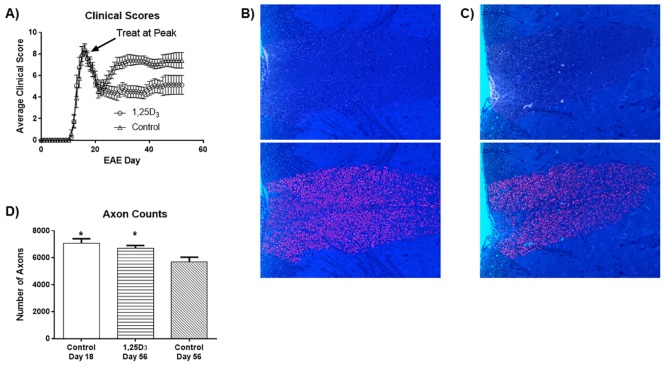
Treatment of EAE mice at peak disease demonstrates sustained improvement in clinical score and sparing of axons.Thirty-six mice were immunized with MOG, and 4 mice were sacrificed at day 18 for baseline histology. The remaining 32 mice were equally divided into 1,25D3 or vehicle treatment group until the end of the experiment where 8 mice each were randomly chosen for histological analyses. (A) 1,25D3 treatment initiated from peak clinical severity (day 18) caused a significant score separation from day 26 (p<0.05, Mann-Whitney Wilcoxon) that persisted for the remainder of the 56 days. (B,C) A representative image of toluidine blue-stained section (top) that was then processed to highlight axons (false-colored red) within myelin rings (see Methods for how the imaging analyses were performed). Panel B is from a 1,25D3-treated mouse, while panel C is from a vehicle-EAE animal. (D) 1,25D3 treatment of EAE mice leads to significant sparing of axons. Indeed, while control (vehicle) mice at day 56 displayed fewer axons than mice at day 18, indicating progressive axonal loss in the ensuing interval, this was prevented by 1,25D3. Values are mean ± SD. Asterisks denote significance of 1,25D3-treated EAE mice and axonal counts at day 18 (peak disease), relative to control day 56 EAE mice. * = p<0.05 compared to control day 56.